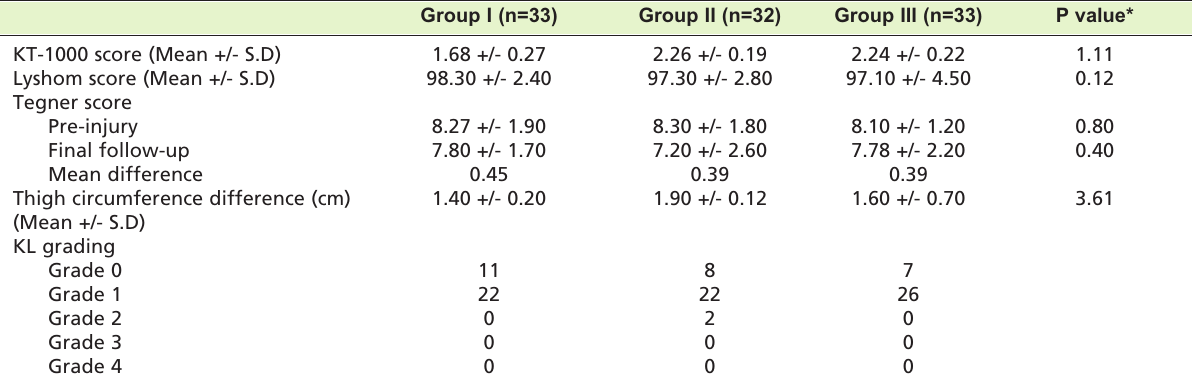
Results in different groups Table IV: